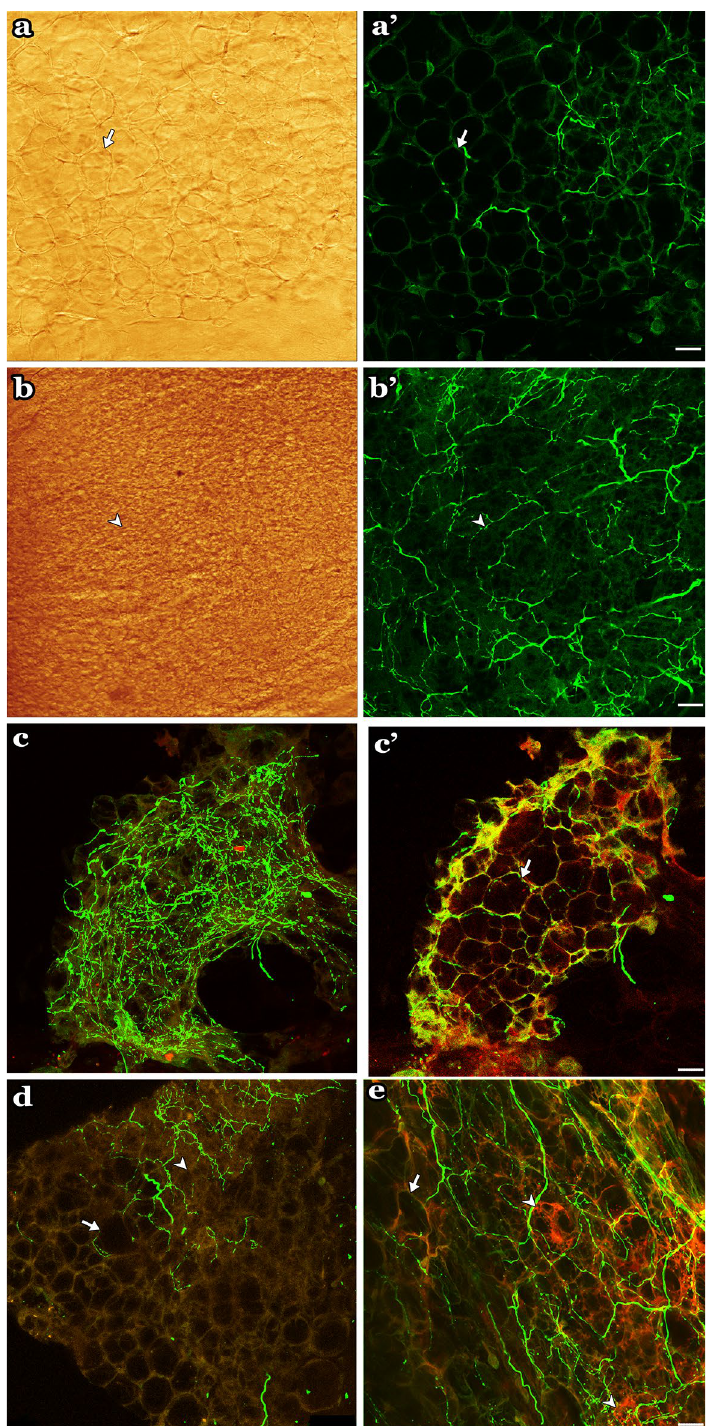
Figure 14. TH-IR axons innervated adipose tissue (white and brown fat cells) ( a ) Single optical section showed WAT morphology using a brightfield channel or ( a’ ) fluorescent channel. b ) Single optical section showed BAT morphology using brightfield or ( b’ ) fluorescent channel . ( c ) Maximal intensity projection image showed both white and brown adipocytes near the atria being heavily innervated by TH-IR axons. ( c’ ) Optical section of the same region in c indicating single TH-IR axons running through and around individual adipocytes. ( c-e ). Autofluorescent excitation by UV laser permitted clear visualization of the fat structure, with varicose axons around both WAT and BAT. Yellow autofluorescence, Green TH-IR. WAT white adipose tissue, BAT brown adipose tissue. Scale bar: 20